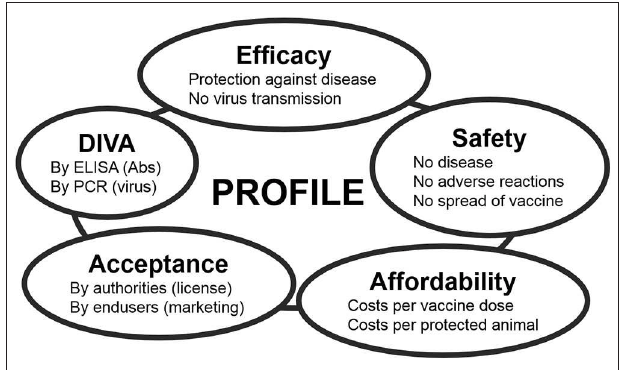
meets all these criteria, but profiles of marketed and experimental vaccines mostly compromise between standards depending on the foreseen aim of vaccination and on the field situation Feenstra and van Rijn